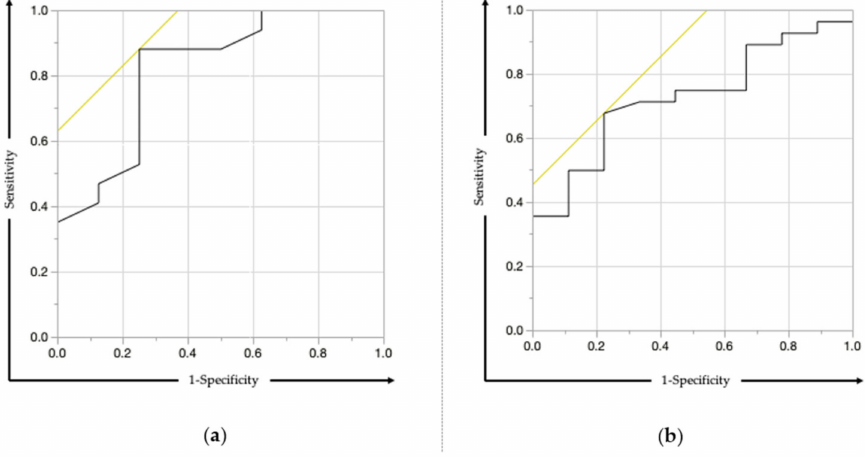
Figure 3. ROC analysis for the prediction of 2-year survival according to the preoperative PNI. ( a ) The AUC was 0.820 in BR-PV patients. ( b ) The AUC was 0.728 in BR-A patients. AUC, area under the curve; PNI, prognostic nutritional